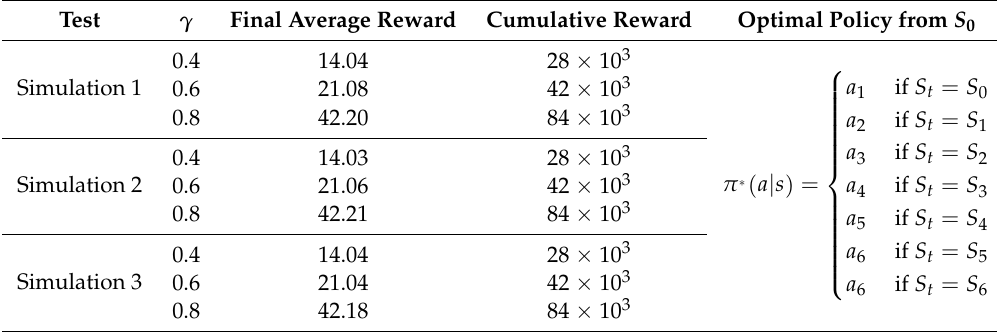
Table 5. Q-learning metrics from three simulations of the algorithm. The algorithm is tested under three different learning rates ( γ ). The final average reward, cumulative reward, and optimal policy are presented.